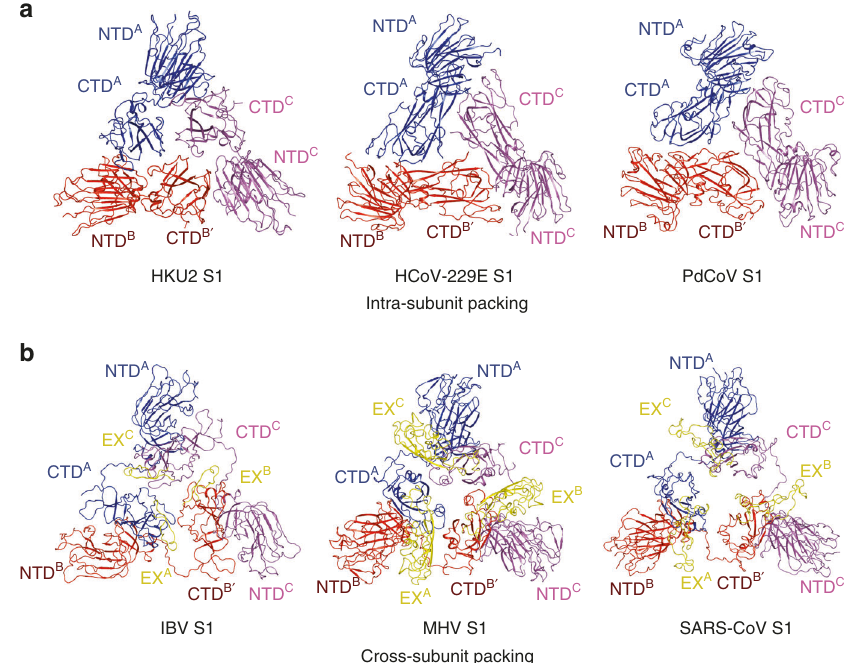
Fig. 5 Quaternary packing of NTD and CTD. a α -coronavirus S1 and δ -coronavirus S1 use intrasubunit packing pattern. NTD and CTD from the fi rst monomer are colored blue, the second are colored red, and the third are colored magenta. PDB codes: HCoV-229E, 6U7H; PdCoV, 6B7N. b β -coronavirus S1 and γ -coronavirus S1 use cross-subunit packing pattern. NTD and CTD from the fi rst monomer are colored blue, the second are colored red, and the third are colored magenta. The extra loop of IBV and the extra domains of β -CoVs are colored yellow and labeled as EX. PDB codes: MHV, 3JCL; IBV, 6CV0; SARS,